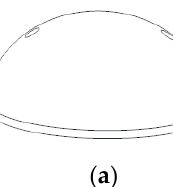
Figure 27. Mist escape distribution on the intake surface: ( a ) 0.6 kPa; ( b ) 0.9 kPa; ( c ) 1.2 kPa; ( d ) 1.5 kPa.